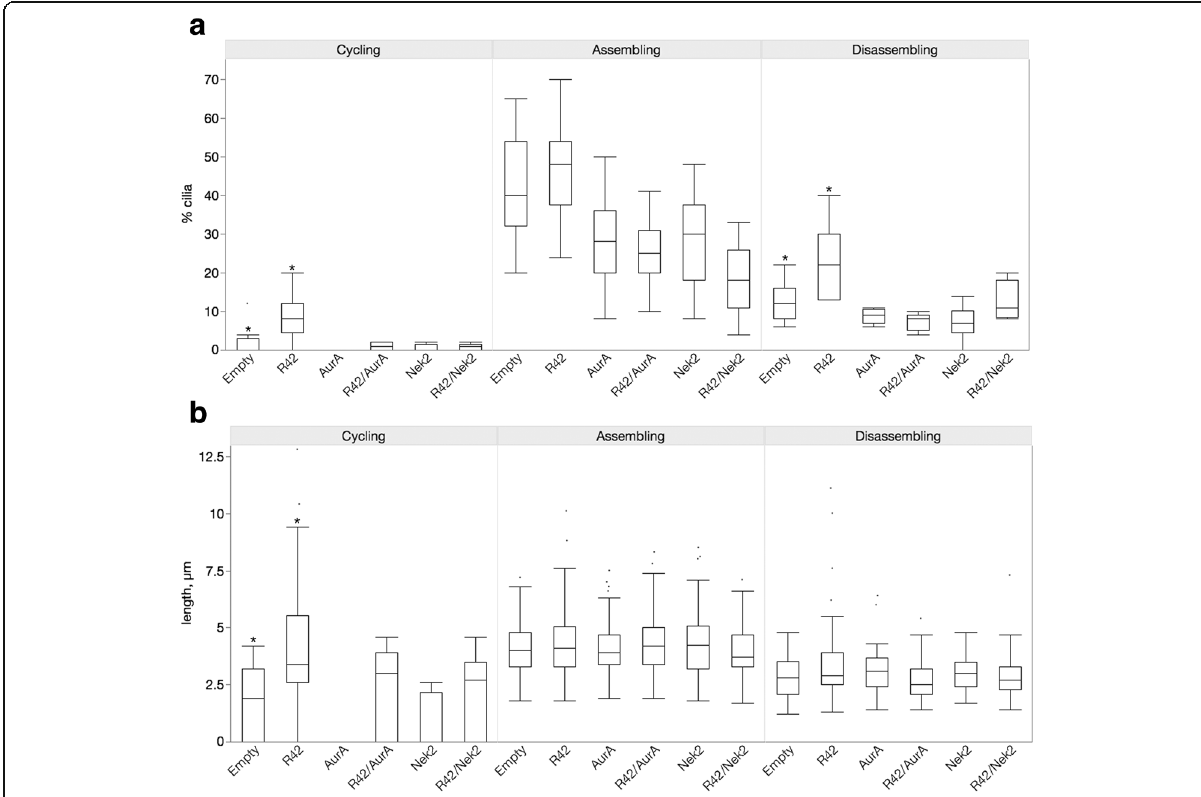
Fig. 9 AurA and Nek2 counteract the stimulatory effect of PPP1R42 on cilia. ARPE-19 cells coexpressing PPP1R42 (R42) with either kinase (R42/ Nek2; R42/AurA), or expressing either kinase alone were grown for 24 h (cycling, left panel), then cilia assembly was induced by serum starvation (assembling, middle panel) following by reintroduction of serum to induce cilia to disassemble (disassembling, right panel). Transfection with empty vector served as negative control. Cilia number ( a ) and length ( b ) were measured at each condition; 300 cells were counted. Significant differences are indicated with asterisks; p ≤ 0.05. The means for cilia number and length ± SEM are shown in Table